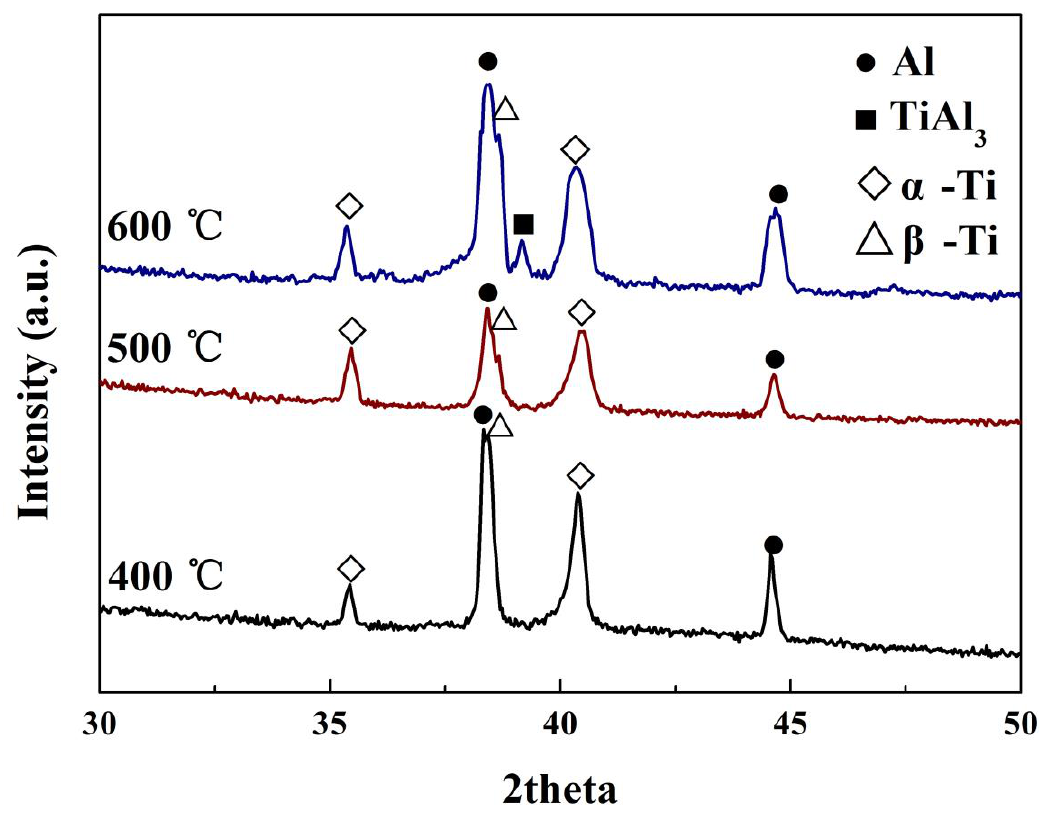
Figure 2. X-Ray di ff raction (XRD) patterns of cross-sectional Ti-6Al-4V alloy sliding at 400 ◦ C, 500 ◦ C and 600 ◦ C for 10